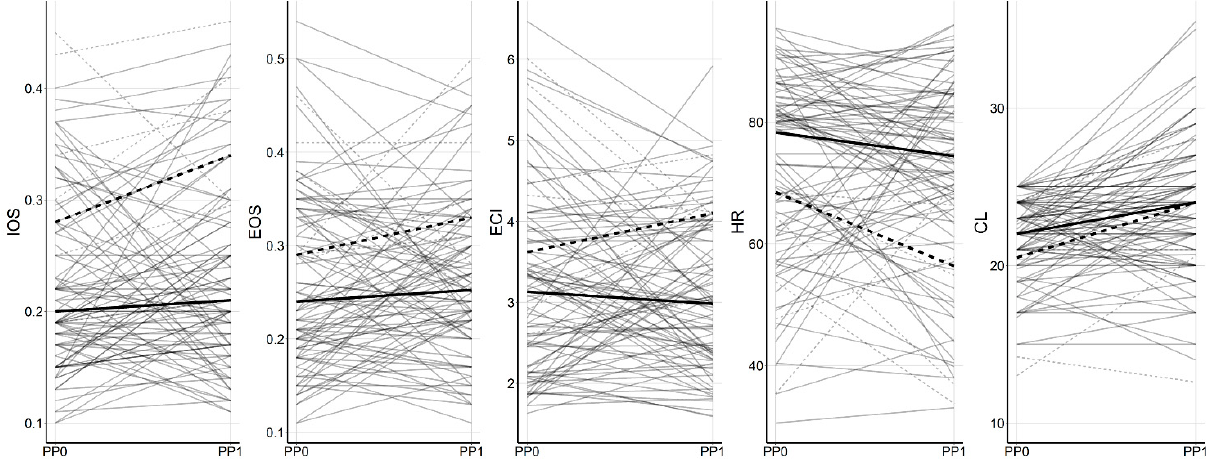
Figure 3. Preprogesterone and postprogesterone changes in elastographic parameters. Solid and dashed lines represent the mean value of the groups of delivery ≥ 32 weeks and delivery <32 weeks, respectively. IOS, mean of internal os strain; EOS, mean of external os strain; ECI, elasticity contrast index; HR, hardness ratio; CL, cervical length; PP0, preprogesterone; PP1, 1 week postprogesterone.